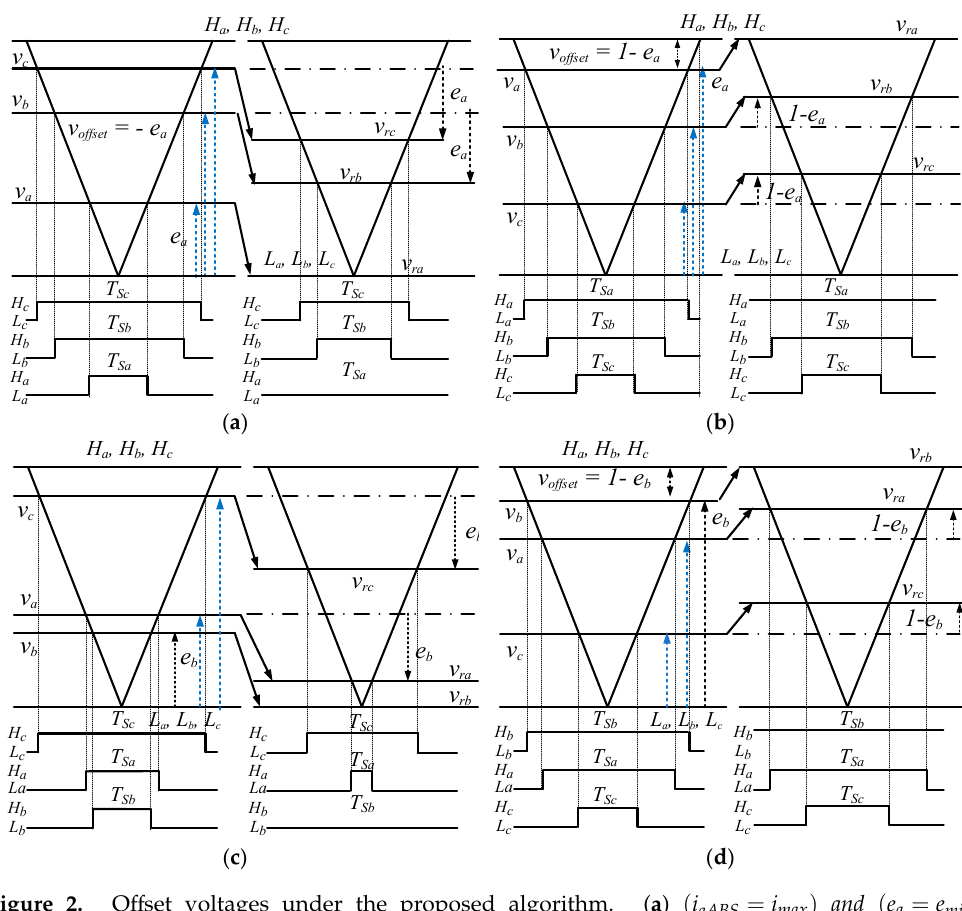
Figure 2. Offset voltages under the proposed algorithm. ( a ) (𝑖 (cid:3028)(cid:3002)(cid:3003)(cid:3020) = 𝑖 (cid:3040)(cid:3028)(cid:3051) ) 𝑎𝑛𝑑 (𝑒 (cid:3028) = 𝑒 (cid:3040)(cid:3036)(cid:3041) ) ; ( b ) (𝑖 (cid:3028)(cid:3002)(cid:3003)(cid:3020) = 𝑖 (cid:3040)(cid:3028)(cid:3051) ) 𝑎𝑛𝑑 (𝑒 (cid:3028) = 𝑒 (cid:3040)(cid:3028)(cid:3051) ) ; ( c ) (𝑖 (cid:3028)(cid:3002)(cid:3003)(cid:3020) ≥ 𝑖 (cid:3029)(cid:3002)(cid:3003)(cid:3020) ≥ 𝑖 (cid:3030)(cid:3002)(cid:3003)(cid:3020) ),(𝑒 (cid:3028) = 𝑒 (cid:3040)(cid:3032)(cid:3031) ) 𝑎𝑛𝑑 (𝑒 (cid:3029) = 𝑒 (cid:3040)(cid:3036)(cid:3041) ) ; ( d ) (𝑖 (cid:3028)(cid:3002)(cid:3003)(cid:3020) ≥ 𝑖 (cid:3029)(cid:3002)(cid:3003)(cid:3020) ≥ 𝑖 (cid:3030)(cid:3002)(cid:3003)(cid:3020) ),(𝑒 (cid:3028) = 𝑒 (cid:3040)(cid:3032)(cid:3031) ) 𝑎𝑛𝑑 (𝑒 (cid:3029) = 𝑒 (cid:3040)(cid:3028)(cid:3051) ) .